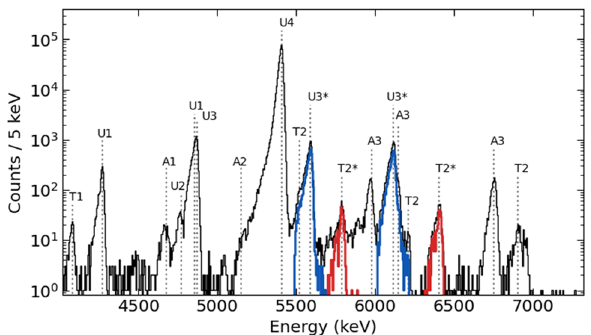
Fig. 4 Energy spectrum of α -events in C2. Each dotted line and the annotation on top of it represent Q α and the corresponding decay sub- chain. Pairs of α - α coincident events in the 238 U and 232 Th series are annotated with stars(*) and indicated by the blue and red histograms, respectively. See Table 3 for more